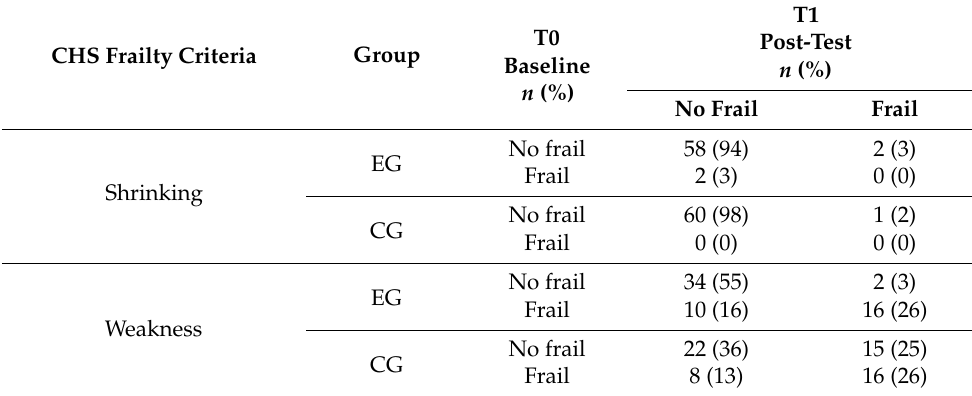
Table 3. Comparison of changes between EG and CG from baseline to post-test for each CHS frailty